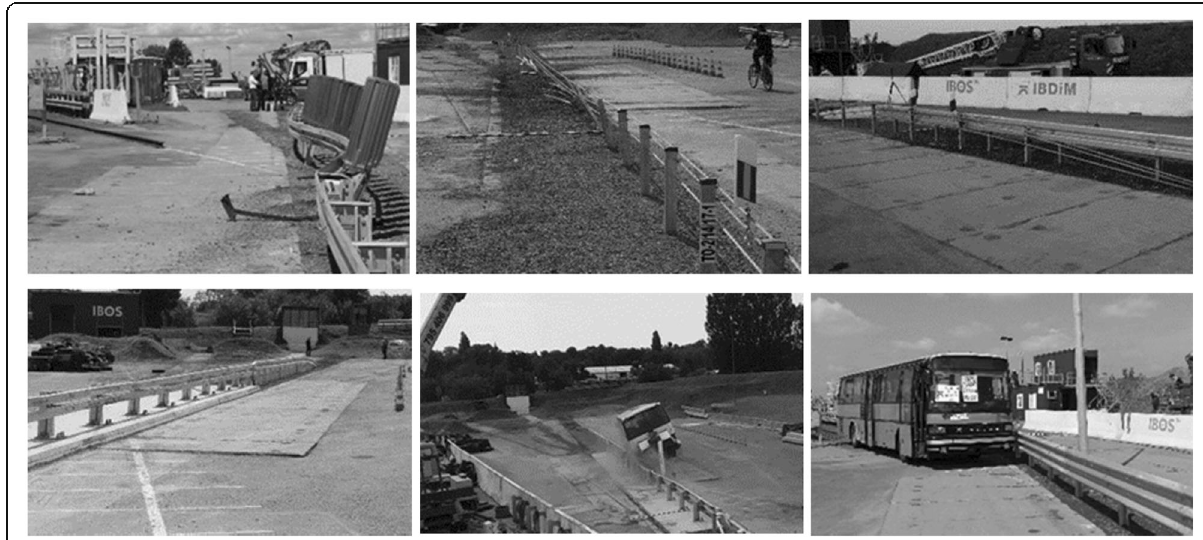
Fig. 1 Photographic crash test documentation, source: the authors